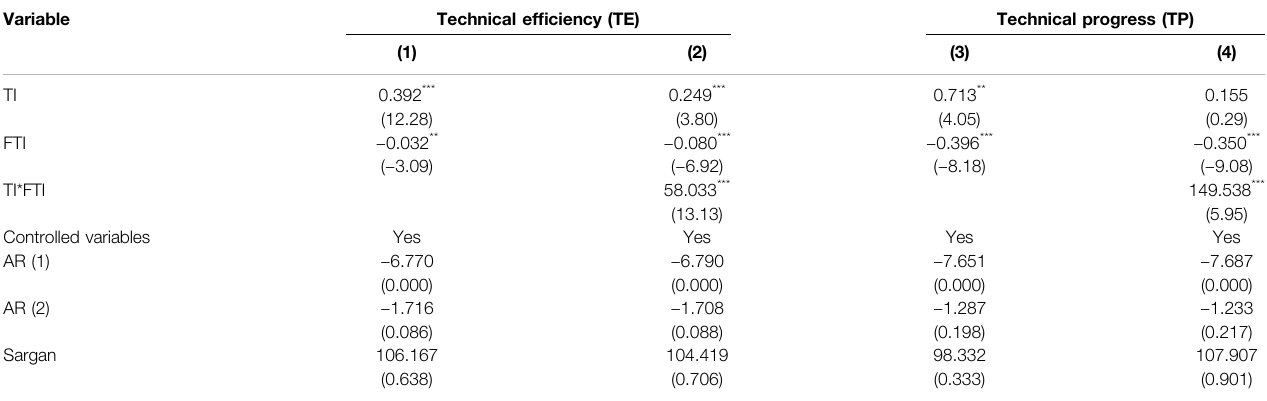
TABLE 5 | Results of the robustness test.